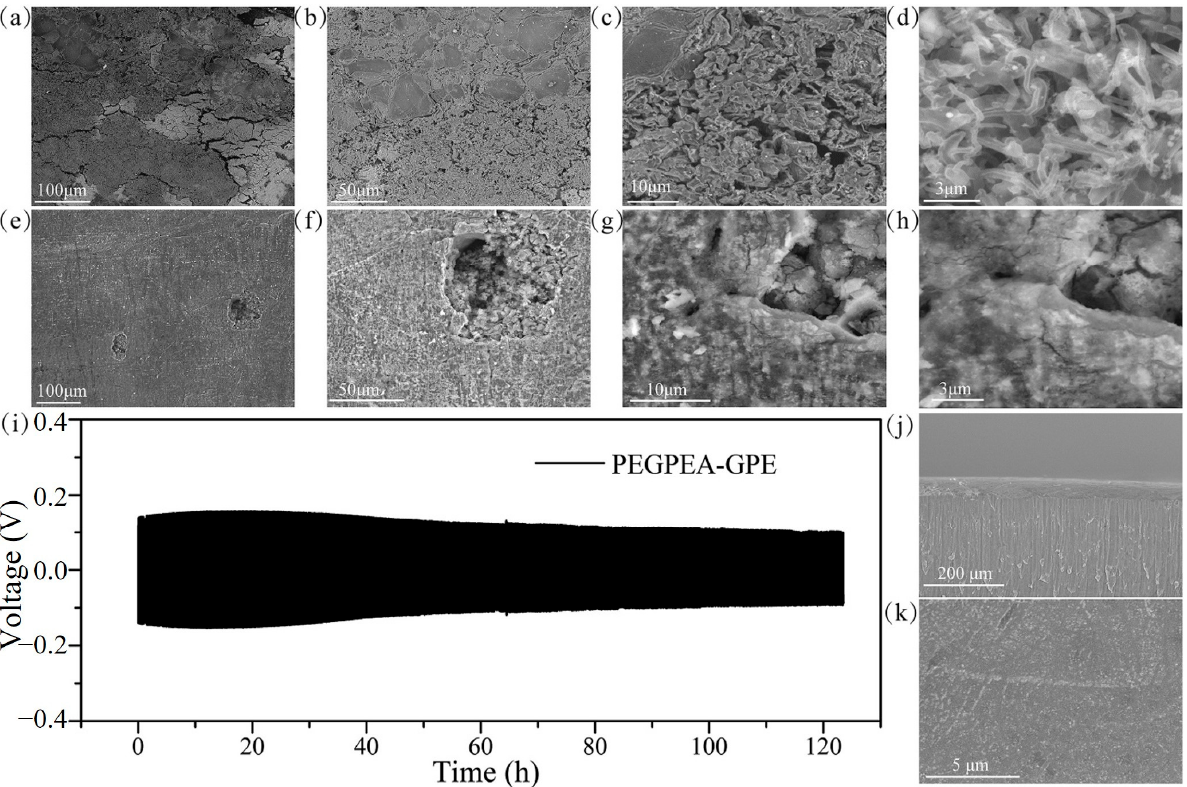
Figure 3. SEM spectra of lithium metal after 70 cycles in 1 M LiPF6-based batteries: ( a – d ); PEGPEA- GPE-based batteries ( e – h ); ( i ) Voltage profile of Li/PEGPEA-GPE/Li cell at 0.10 mA cm − 2; ( j ) Cross- sectional view and ( k ) top view SEM spectra of lithium metal after Li/PEGPEA-GPE/Li cycle test. Reprinted/adapted with permission from Ref. [91]. Copyright ® 2018, Elsevier B. V.